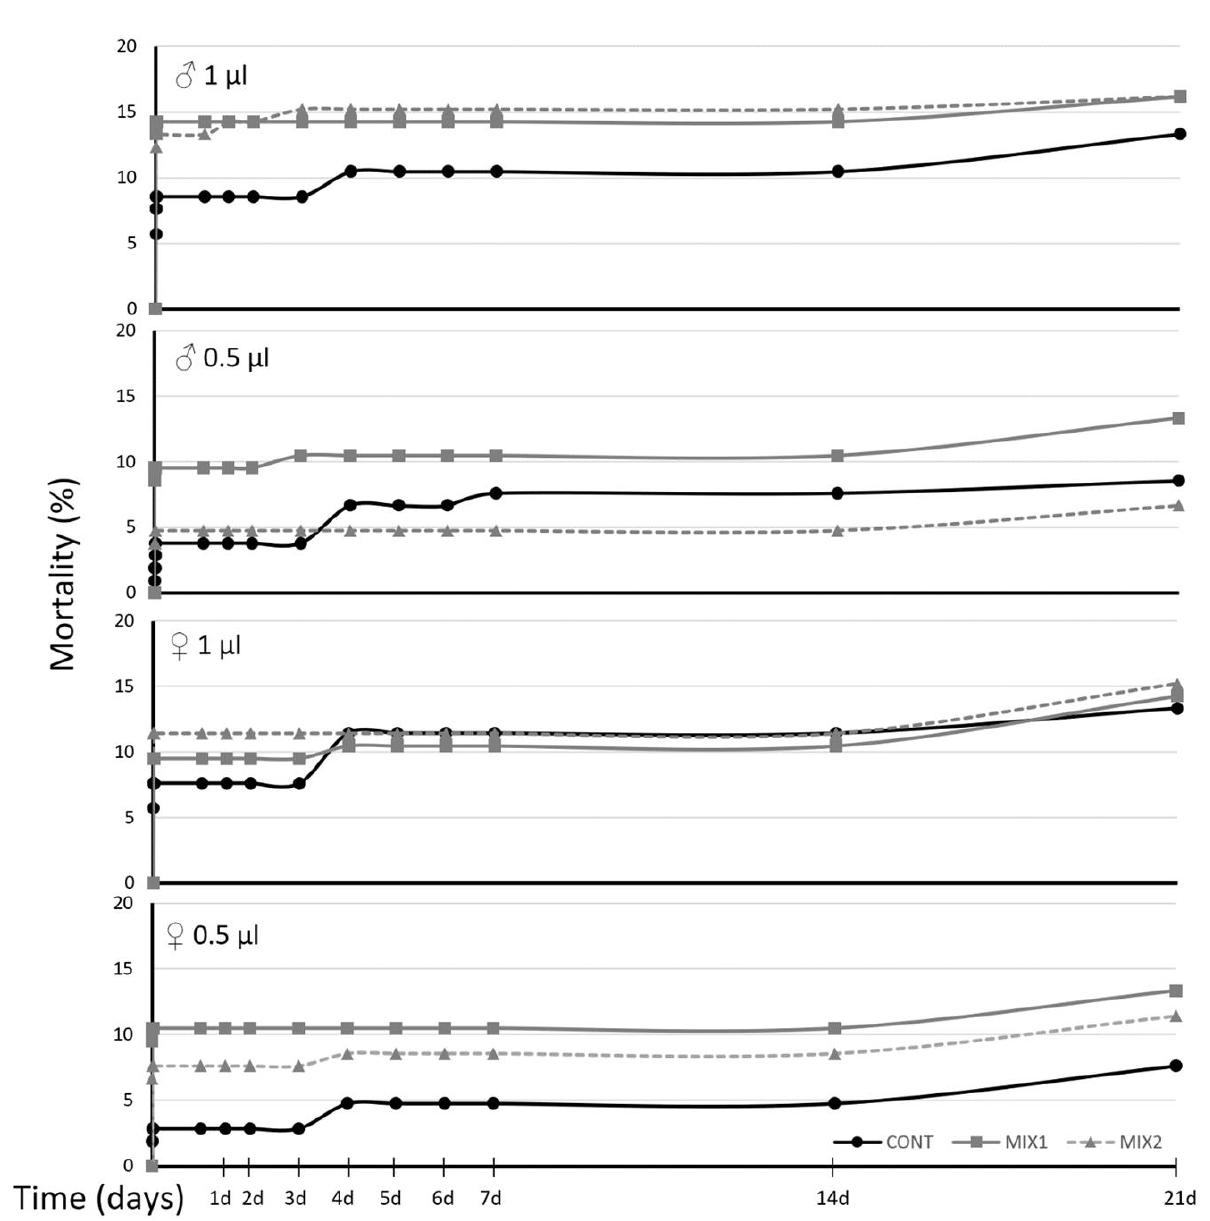
Figure 2. Mortality (%) recorded during the 7 replications of topic bioassays on adult OLF. Cont. = Control made with water drops; MIX2 = drop of mixture in equal parts of the SWs obtained from cellulose, wood, corn and alfalfa at both 300 °C and 500 °C; MIX1 = drop of mixture in equal parts of the SWs obtained from olive mill waste at both 300 °C and 500 °C.